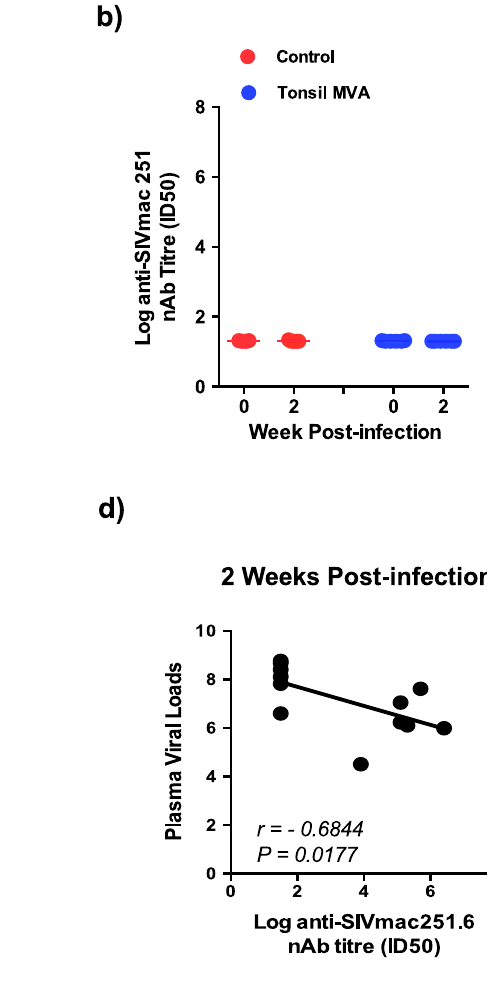
error.( b )SIVmac251speci fi cneutralizing antibodyresponsesincontrol( n